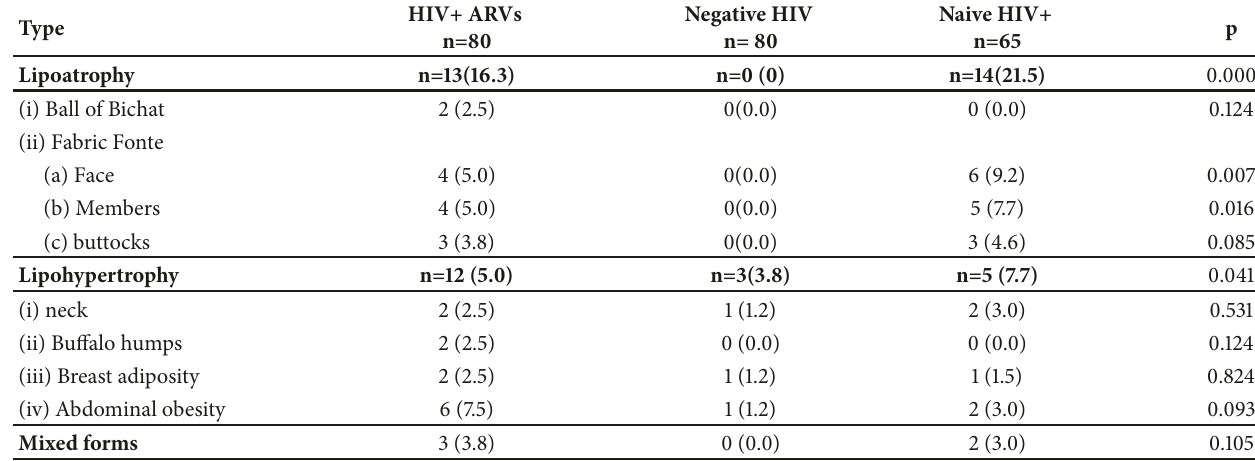
Table 2: Distribution of lipodystrophy according to the type, location, and